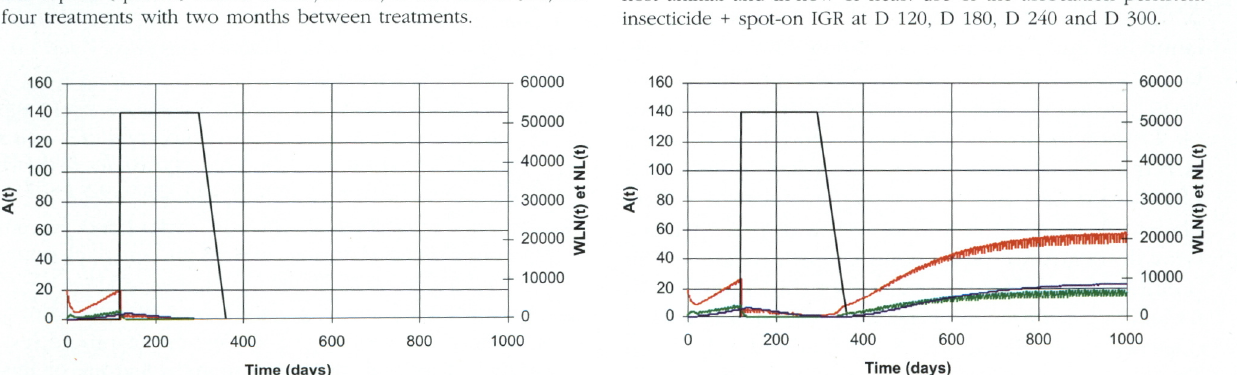
Fig. 20. - Treatment of host animal combining persistent insecticide and topical (spot-on) IGR every two months i.e. three treatments (at D 120, D 180 and D 240) but with regular vacuum cleaning of the apartment once a week.